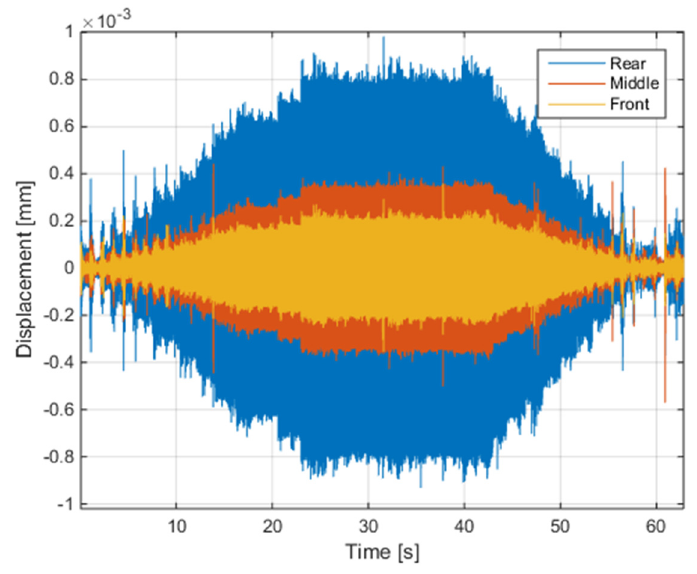
Figure 11. Vibration in three points on the machine.